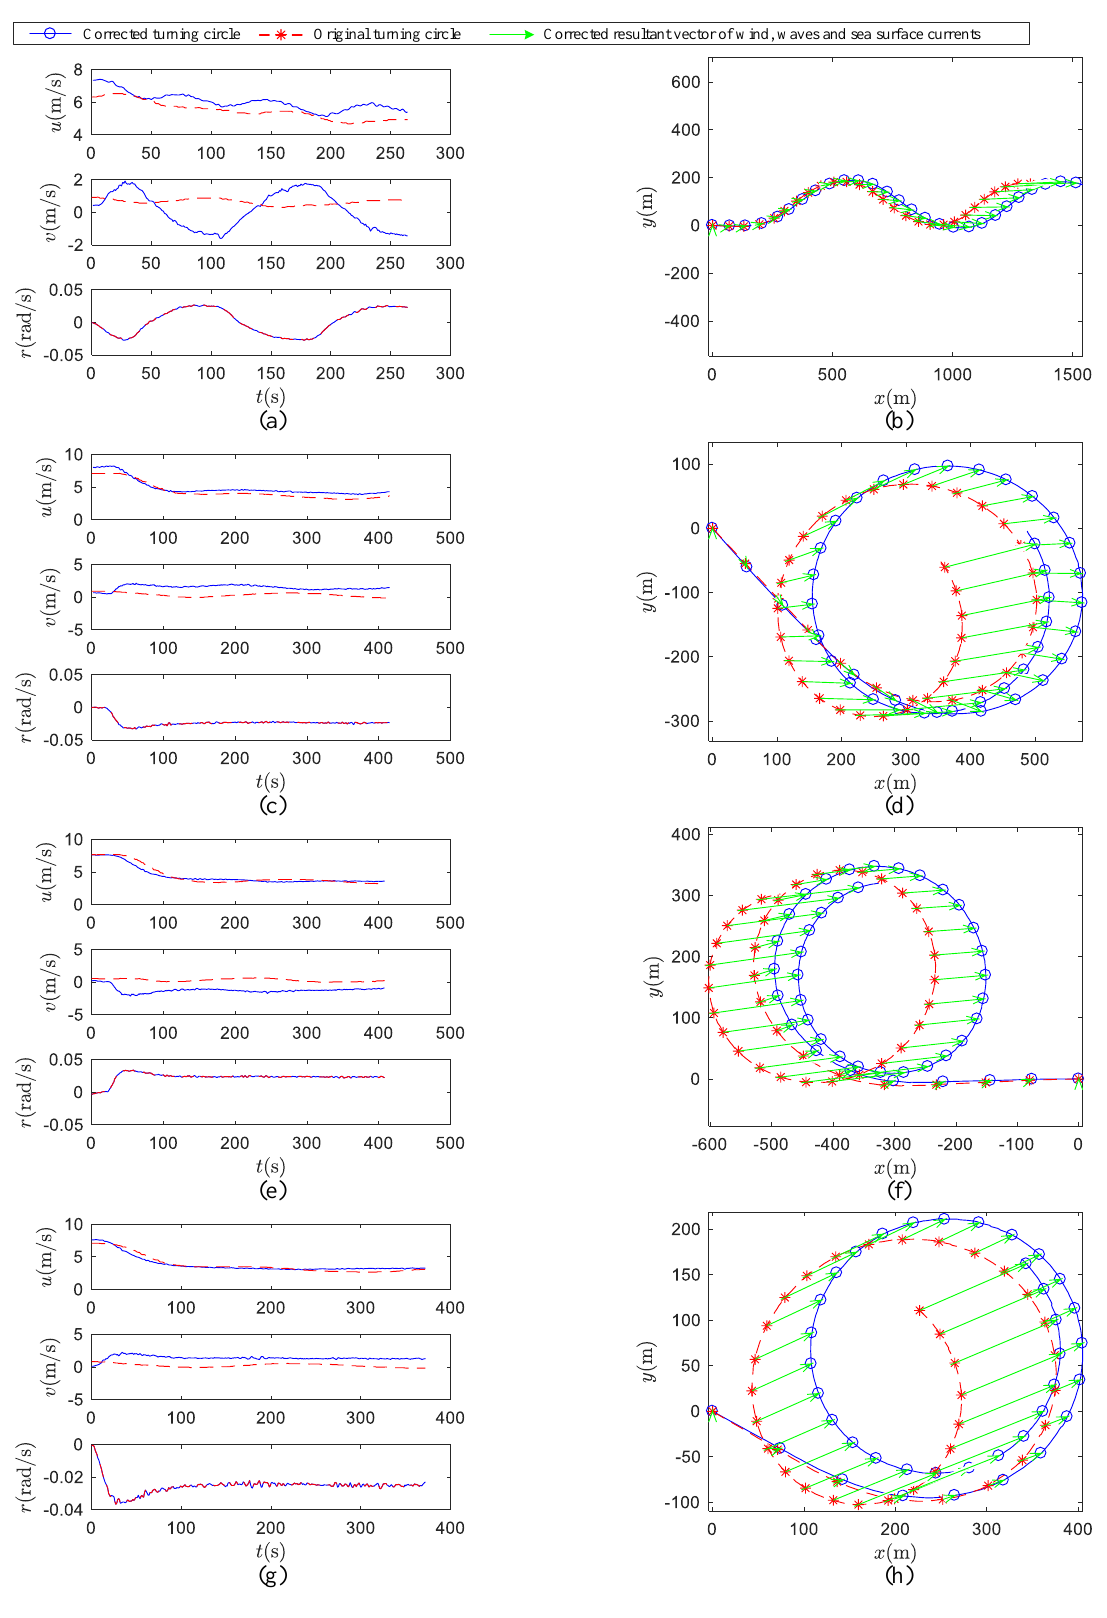
Figure A4. Correction result of track and velocities for test NO. 9–12. ( a ) Track of NO.9; ( b ) velocities of NO.9; ( c ) track of NO.10; ( d ) velocities of NO.10; ( e ) track of NO.11; ( f ) velocities of NO.11; ( g ) track of NO.12; ( h ) velocities of NO.12.